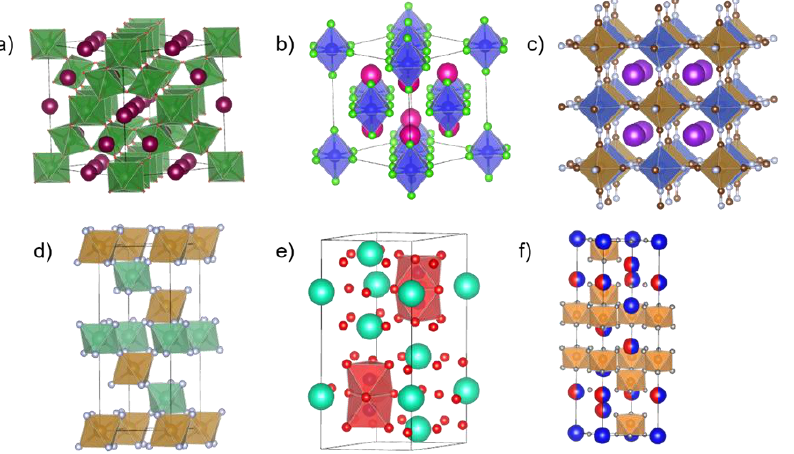
Figure 4. Some of the compounds initially labeled as “others” were retrieved with one of the structure types of Figure 1: ( a ) Pb 2 ReMnO 6 ( Fd 3 m ) had the characteristic framework of the perovskite structure; ( b ) Rb2ZrCl 6 ( Fm 3 m ) had the perovskite structure where half of the octahedra were occupied by Zr; ( c ) K 2 FeCu(CN) 6 ( Fm 3 m ) had the characteristic octahedral framework spaced by cyanide units; ( d ) NbFeF 6 ( R 3 ) had the perovskite structure without occupied cuboctahedral sites; ( e ) Cs 3 W 2 Cl 9 ( P 6 3 / mmc ) had the hexagonal perovskite structure, without occupied octahedra connecting face-shared columns; and ( f ) RbBa 2 Fe 2 F 9 ( R 3 m ), had the perovskite structure with vacant octahedra within the face-shared columns.